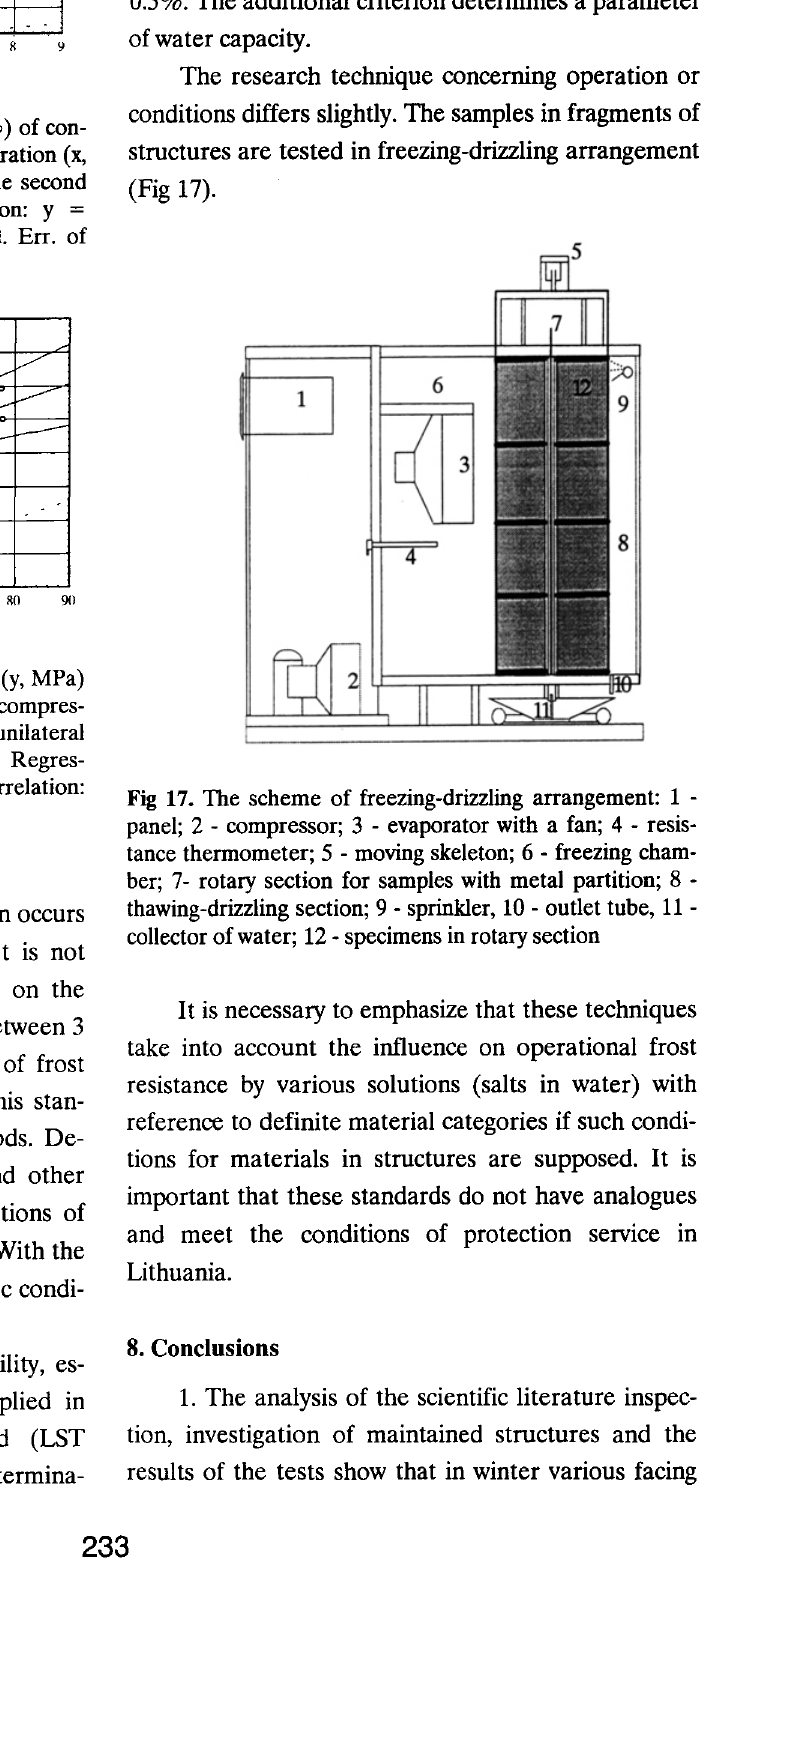
Fig 15. Relationship between final saturation (y, %) of con crete samples for volumetric freezing and final saturation (x, %) of identical samples for unilateral freezing (the second series of comparative tests). Regression equation: y = 3.2528 + 0.07742 x. Correlation: 0.1333961. Std. Err. of